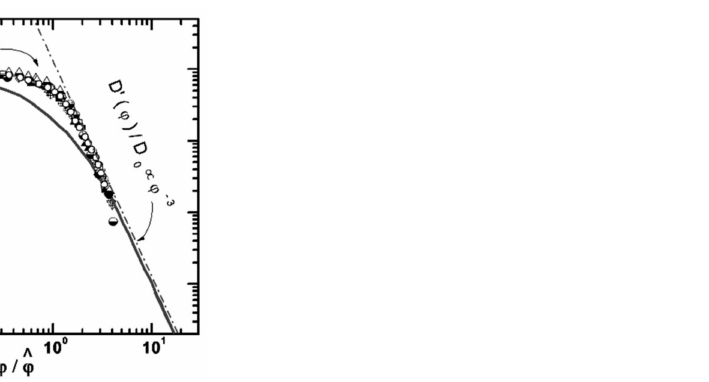
Figure 53. Generalized concentration dependence on concentration of the self ‐ diffusion coeffi ‐ cients of globular proteins molecules [130]. The figure shows the experimental values for BSA (pH = 4.8–5.2), myoglobin (pH = 6.8–7.2), lysozyme (pH = 2.9–3.0 and pH = 7.4–7.8), barstar (pH = 8.0– 8.2). The solid line is the generalized self ‐ diffusion coefficients concentration dependence of the flexible ‐ chain polymers [132]. φ(cid:3549) –critical concentration, found as the intersection of the asymptote with zero slope ϕ − 3 , drawn to the experimental concentration dependences of the self ‐ diffusion coefficients of